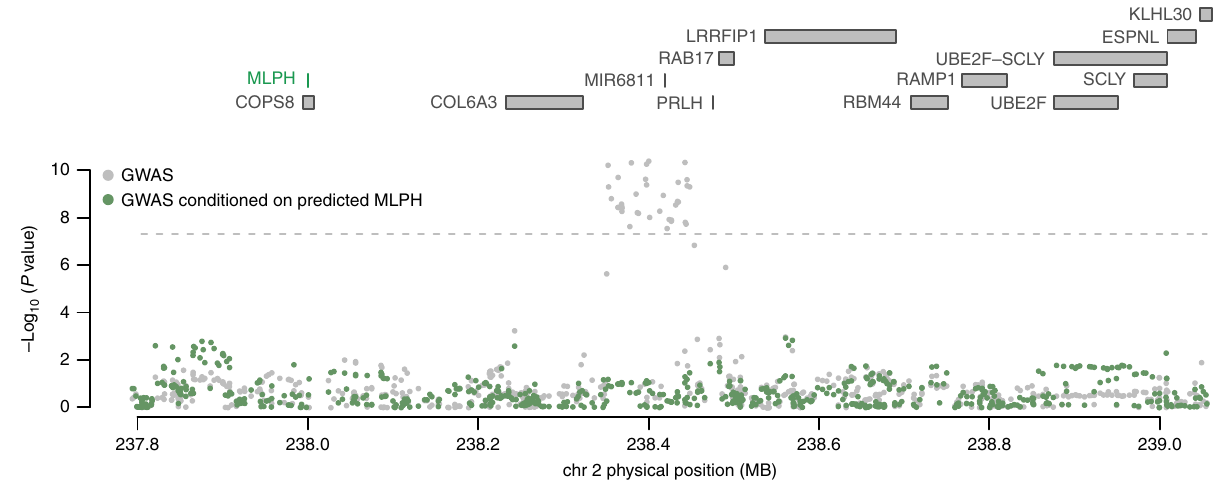
Fig. 3 Predicted expression of MLPH explains majority of GWAS signal at its genomic region. Each point corresponds to the association between SNP and PrCa status. Gray points indicate the marginal association of a SNP with PrCa status (i.e., GWAS association). Green points indicate the association of the same SNPs with PrCa after conditioning on predicted expression of MLPH using models trained from normal prostate (GTEx) and tumor prostate (TCGA). The dashed gray line corresponds to the genome-wide signi fi cant threshold (i.e., P = 5 × 10 − 8 ). MLPH was discussed in previous works as a possible susceptibility gene for PrCa. Association between total expression of MLPH and PrCa risk was transcriptome-wide signi fi cant in normal and tumor